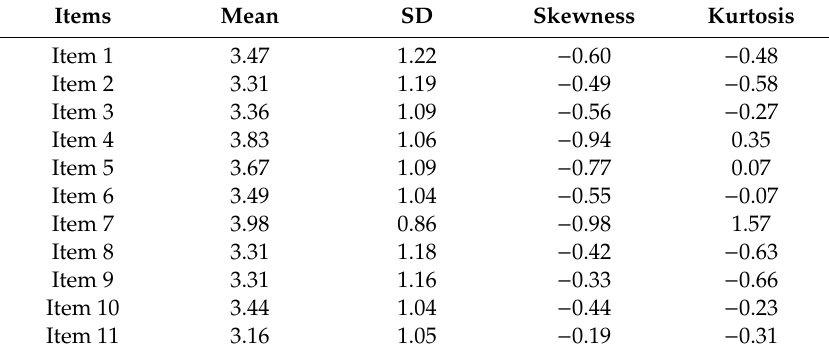
Table 1. Items’ descriptive statistics.